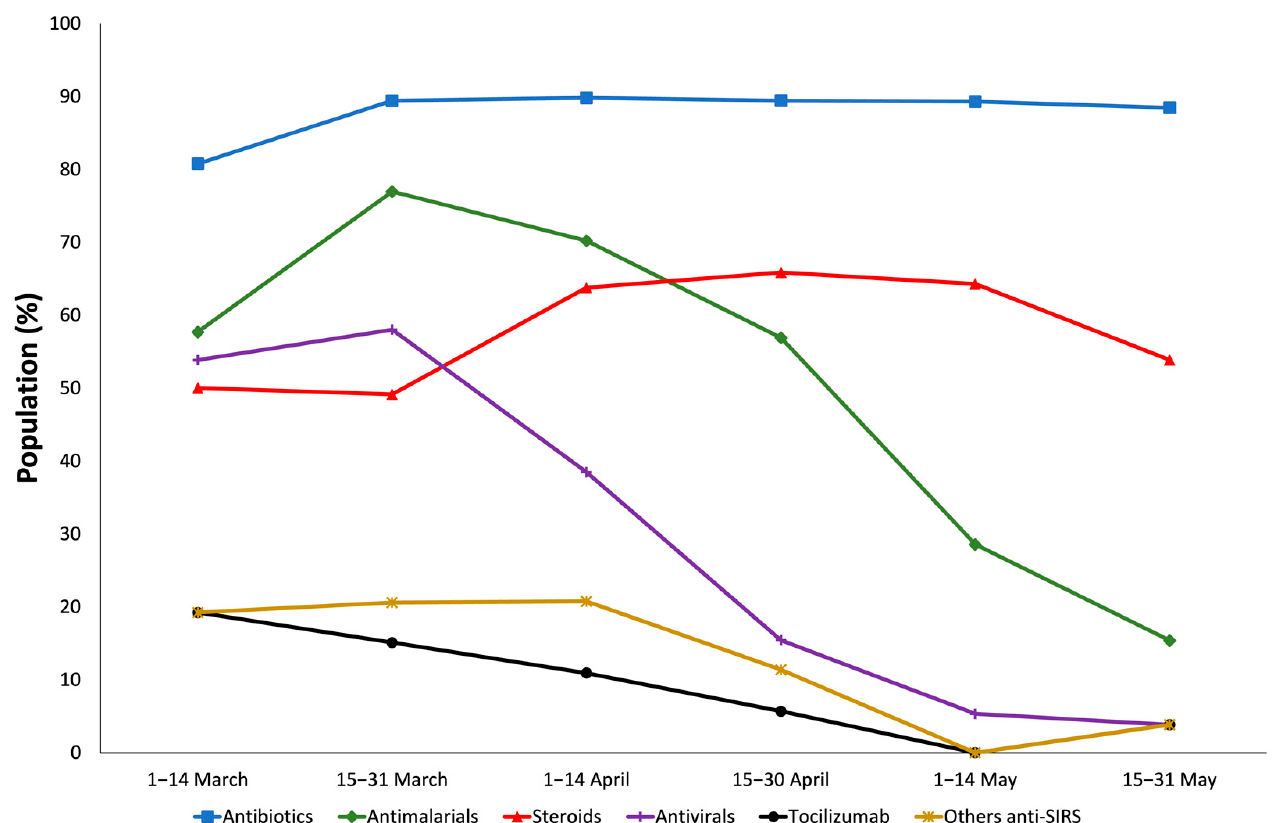
Figure 2. Trends in the use of the medicines used by in-hospital COVID-19 patients with severe acute respiratory syndrome in Castile and Leon (Spain) (1 March–31 May 2020). Table 3. Medicines used by in-hospital COVID-19 patients with severe acute respiratory syndrome